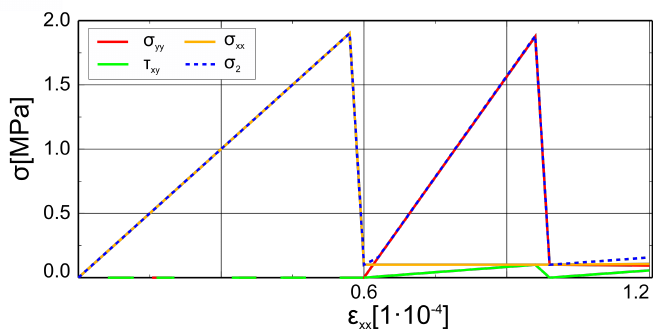
Figure 14. Willam’s test—change of stress values in the two